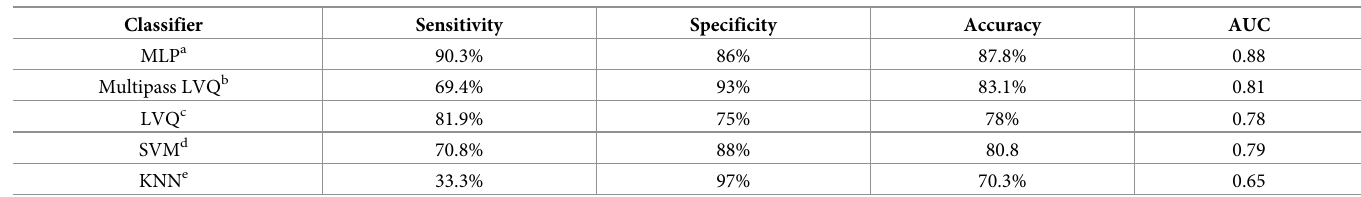
Table 2. Classification results for the whole data.